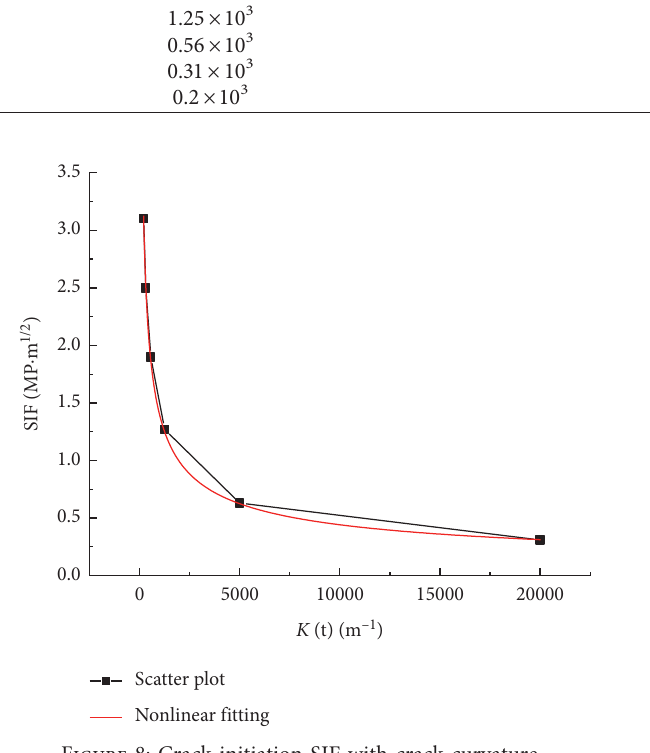
Figure 8: Crack initiation SIF with crack